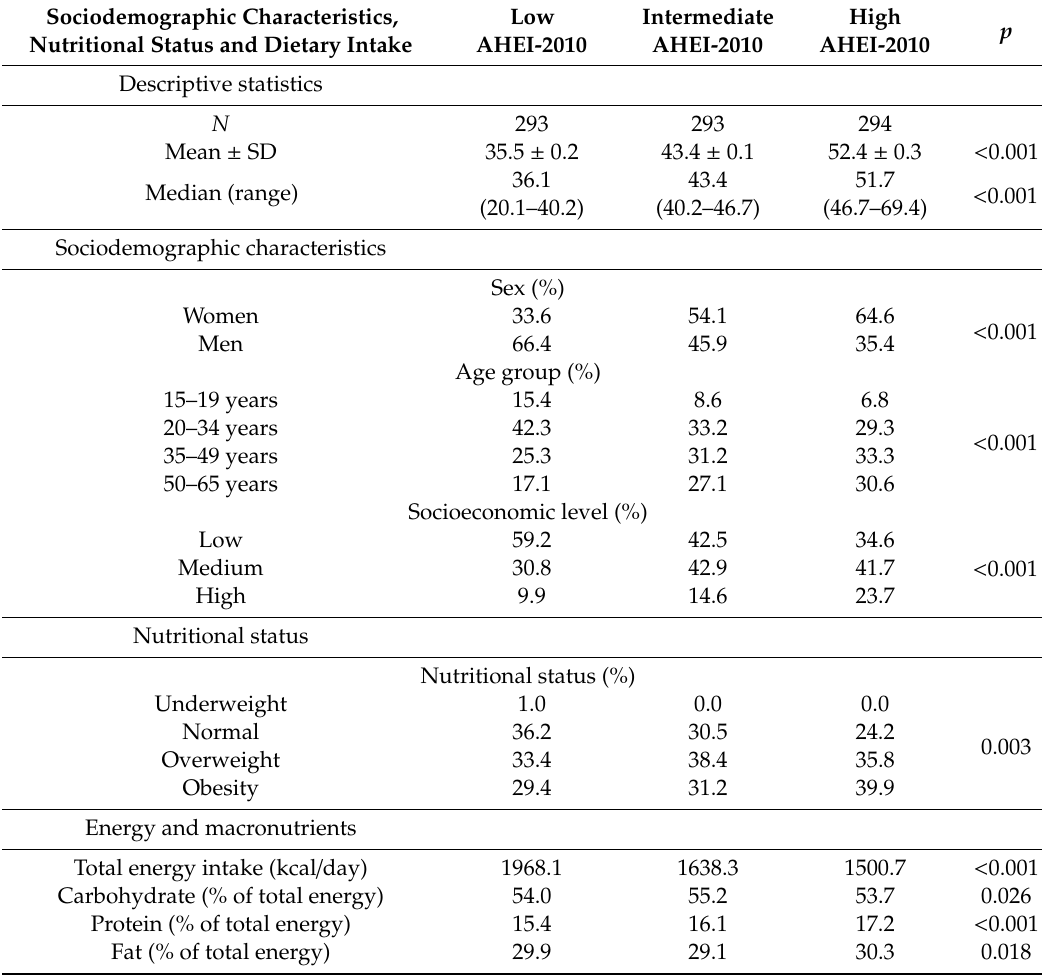
Table 3. Description of Alternate Healthy Eating Index 2010 score categorized in by terciles according to sociodemographic characteristics, nutritional status and dietary intake (energy and macronutrients) characteristics in Chilean urban population enrolled in ELANS